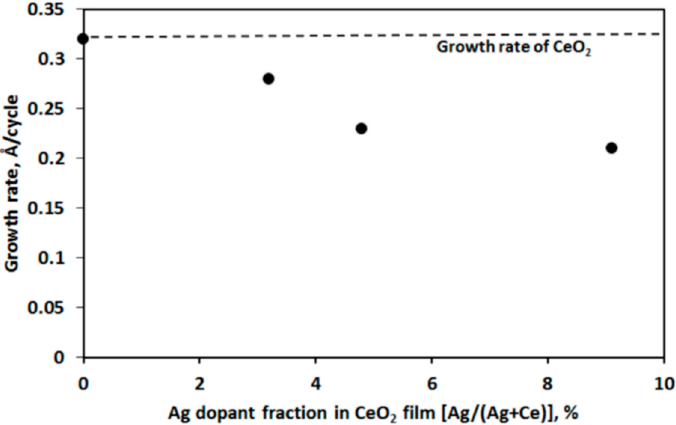
Figure 4. The effect of Ag concentration on the growth rate of Ag doped CeO 2 thin films at 200 °C reactor temperature.